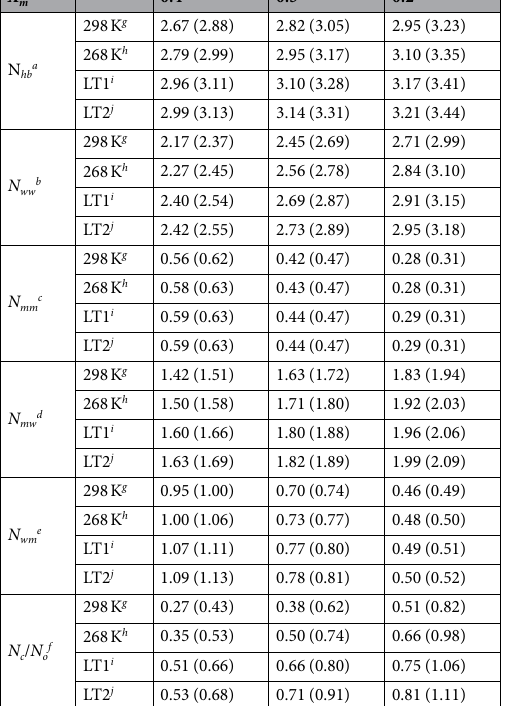
Table 1. Hydrogen-bond statistics in the systems studied, as calculated for the energetic definition of hydrogen bonds (values in parantheses correspond to the geometric definition of H-bonds). a Average number of hydrogen bonds per molecule; b average number of H-bonded water molecules around water; c average number of H-bonded methanol molecules around methanol; d average number of H-bonded water molecules around methanol; e average number of H-bonded methanol molecules around water; f average number of cyclic entities per molecule; g actual temperature over freezing point ratio (T/T f ): 1.40, 1.31, 1.21; h actual temperature